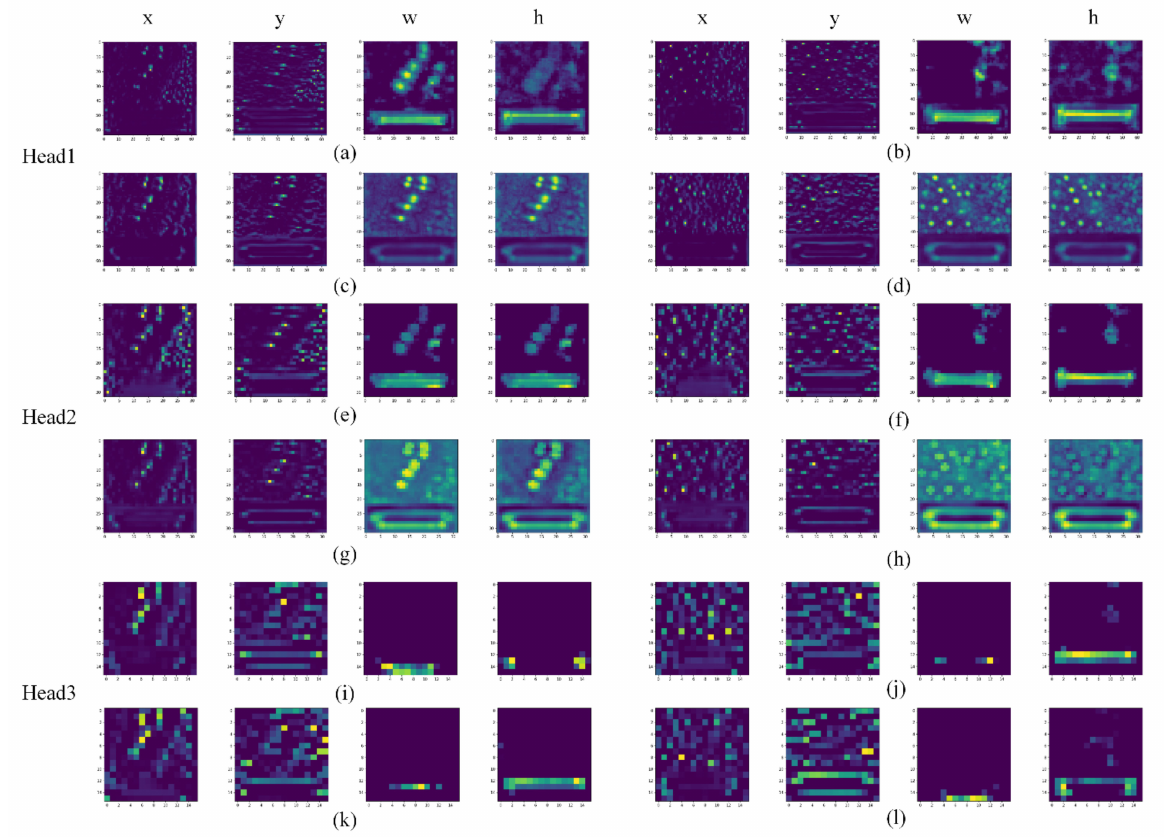
Figure 18. Feature map visualization results of three-scale prediction layers with and without Bi-DFFM. ( a , b , e , f , i , j ) represent results without Bi-DFFM. ( c , d , g , h , k , l ) represent results with